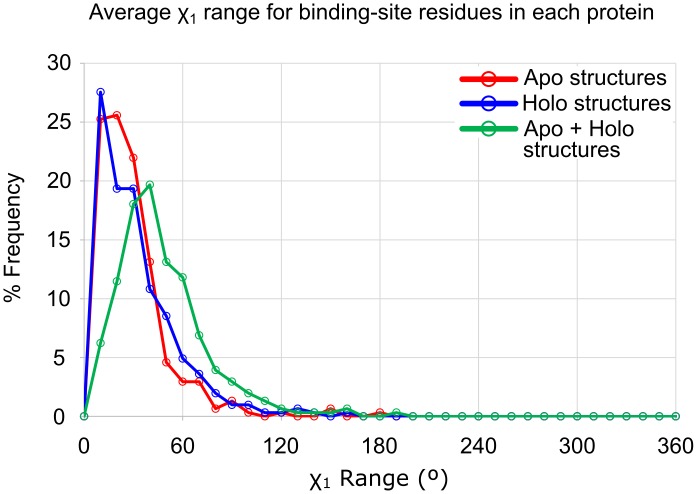
Distribution of the average χ1 range in each binding site.The ranges observed across the apo structures are shown in red, and the ranges across the holo structures are shown in blue. The line in green shows the χ1 ranges measured when the apo and holo structures are analyzed together (apo+holo). The medians of the average χ1 range are 19° for the apo structures, 21° for the holo structures, and 37° for the apo+holo structures. The flexibility of the apo and holo states is approximately the same with no statistical significance in their difference (p > 0.05). When the structures are combined, much greater variation is seen in the maximum χ1 range. The difference between the medians of the apo+holo and apo structures is 18° (p < 0.0001), and the difference to the holo structures is 16° (p < 0.0001).